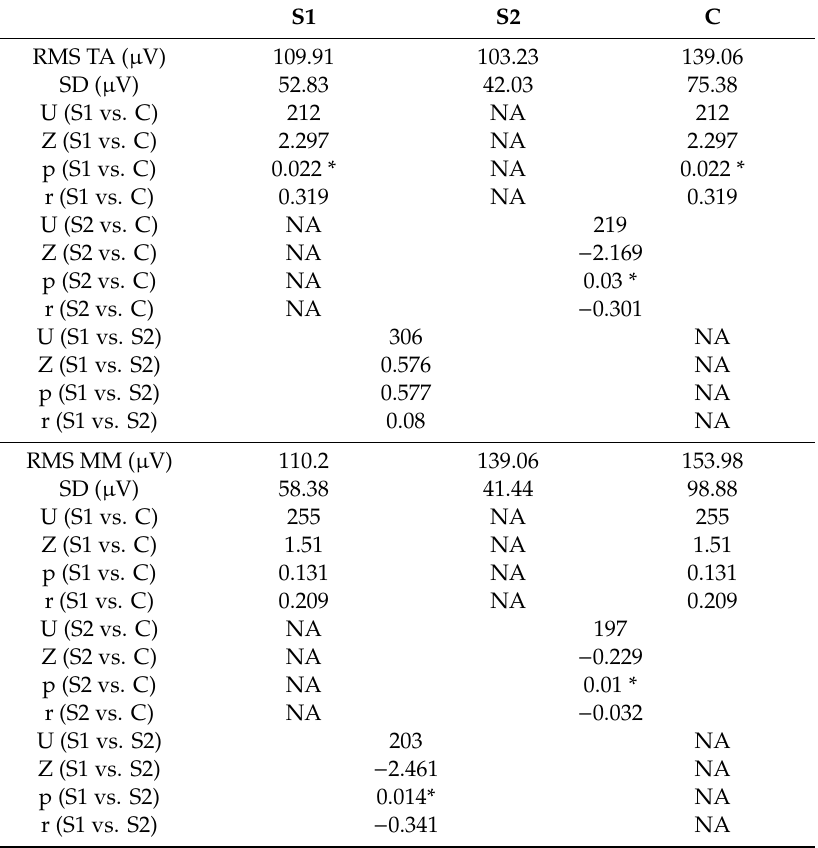
Table 3. Comparing means of bioelectric activity of temporalis anterior (RMS TA) and masseter muscle (RMS MM) during maximum voluntary